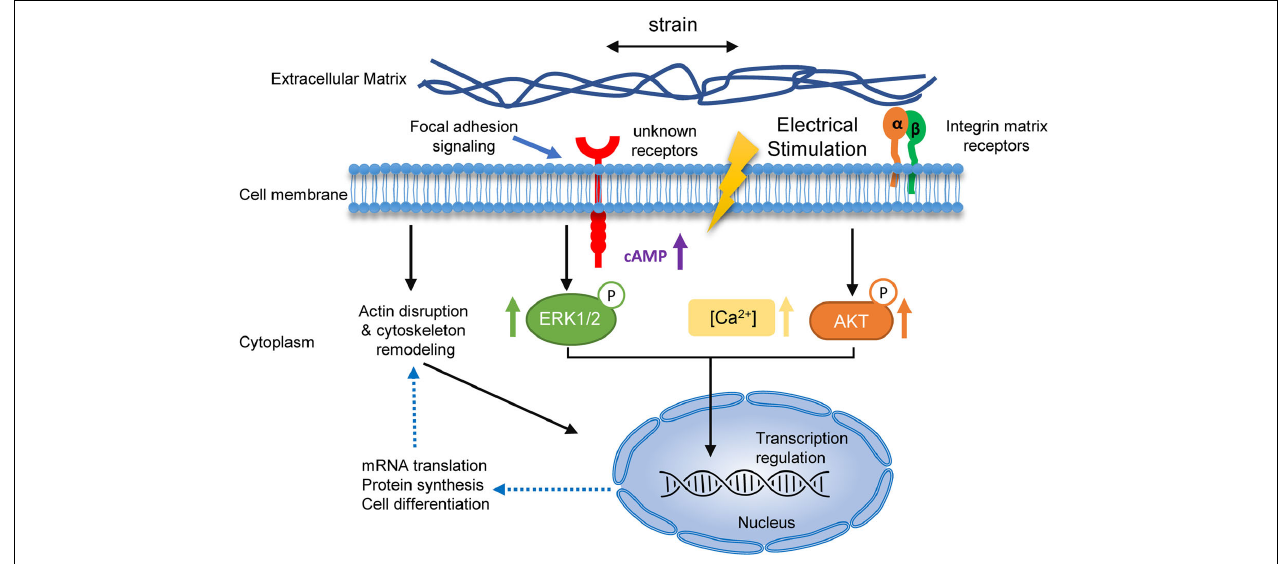
FIGURE 9 | A hypothetical mechanism for the role of cyclic strain and electrical co-stimulation in promoted BMSCs neural differentiation. Schematic summary of the mechanism of strain and EF co-stimulation-induced BMSC neural differentiation. The strain and EF cause changes of ECM, which are sensed by specific receptors and integrins on the cell membrane, resulting in receptor-mediated cell mechanosensing. Activation of these receptors leads to a series of events, including actin disruption and cytoskeleton remodeling, rising of calcium and cAMP, and phosphorylation of ERK and AKT. Signals transduce into the nucleolus and then regulate neural differentiation-related mRNA transcription and protein synthesis, and in return regulate actin formation in